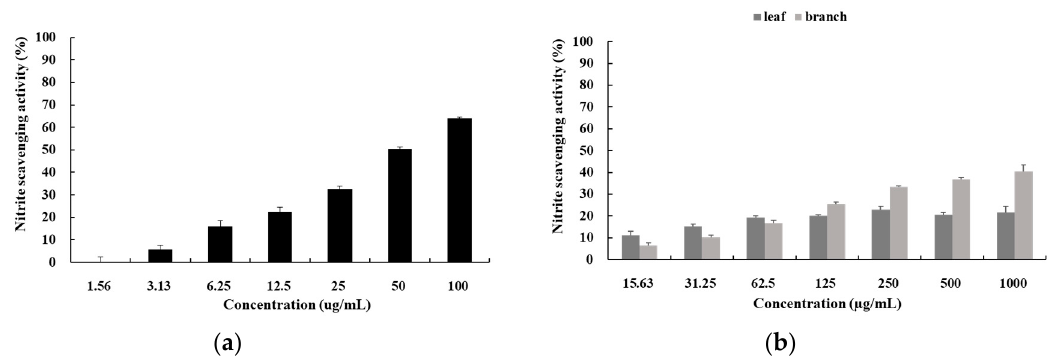
Figure 4. Nitrite scavenging activities of ( a ) L-ascorbic acid and ( b ) hot-water extracts from S. samarangense . An appropriate amount of ascorbic acid was used as a positive control. The results were expressed as the mean ± SD of data obtained from three independent experiments.